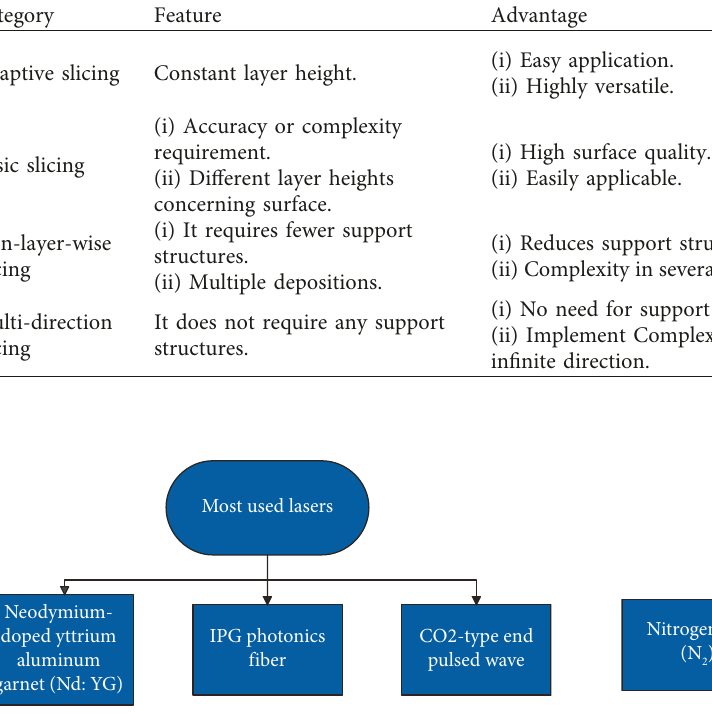
Figure 17: Frequently used lasers.